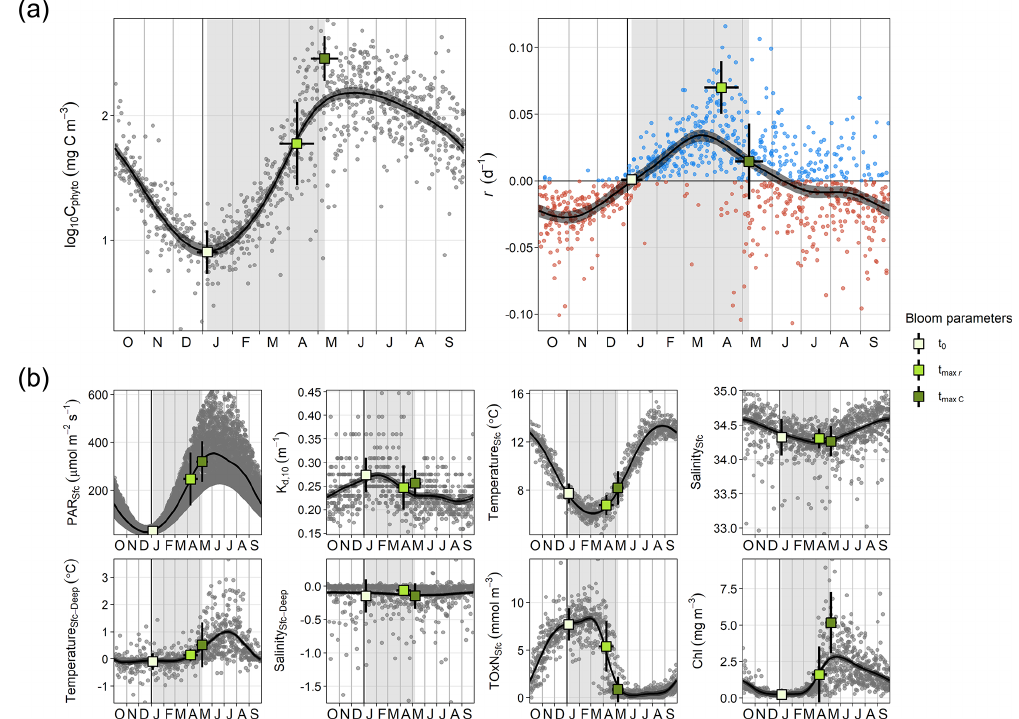
Figure 2. Seasonal cycle of physicochemical and phytoplankton variables. (a) Log-transformed phytoplankton biomass ( C phyto ) concen- tration and biomass accumulation rate ( r ), which were used to estimate the timing of the spring bloom parameters: the spring bloom onset ( t 0 ), the maximum r ( t max r ), and the spring bloom peak ( t maxC ) . (b) Surface photosynthetic active radiation (PAR), attenuation coefficient for the 0–10m layer ( K d , 10 ), surface temperature and salinity (Temperature Sfc and Salinity Sfc , respectively), difference between surface and bottom temperature and salinity (Temperature Sfc-Deep and Salinity Sfc-Deep , respectively), total surface oxidized nitrogen concentration (TOxN fc ), and chlorophyll a (Chl) concentration. Dots (gray or blue and red for positive and negative r , respectively) correspond to indi- vidual values. Black curves and the associated gray shaded areas define, respectively, the average seasonality and 95% confidence interval based on a generalized additive model (GAM). Vertical gray stripes mark the average spring bloom span. Average ± SD timing of different bloom parameters and associated average ± SD environmental conditions are also shown (squares and corresponding error bars).